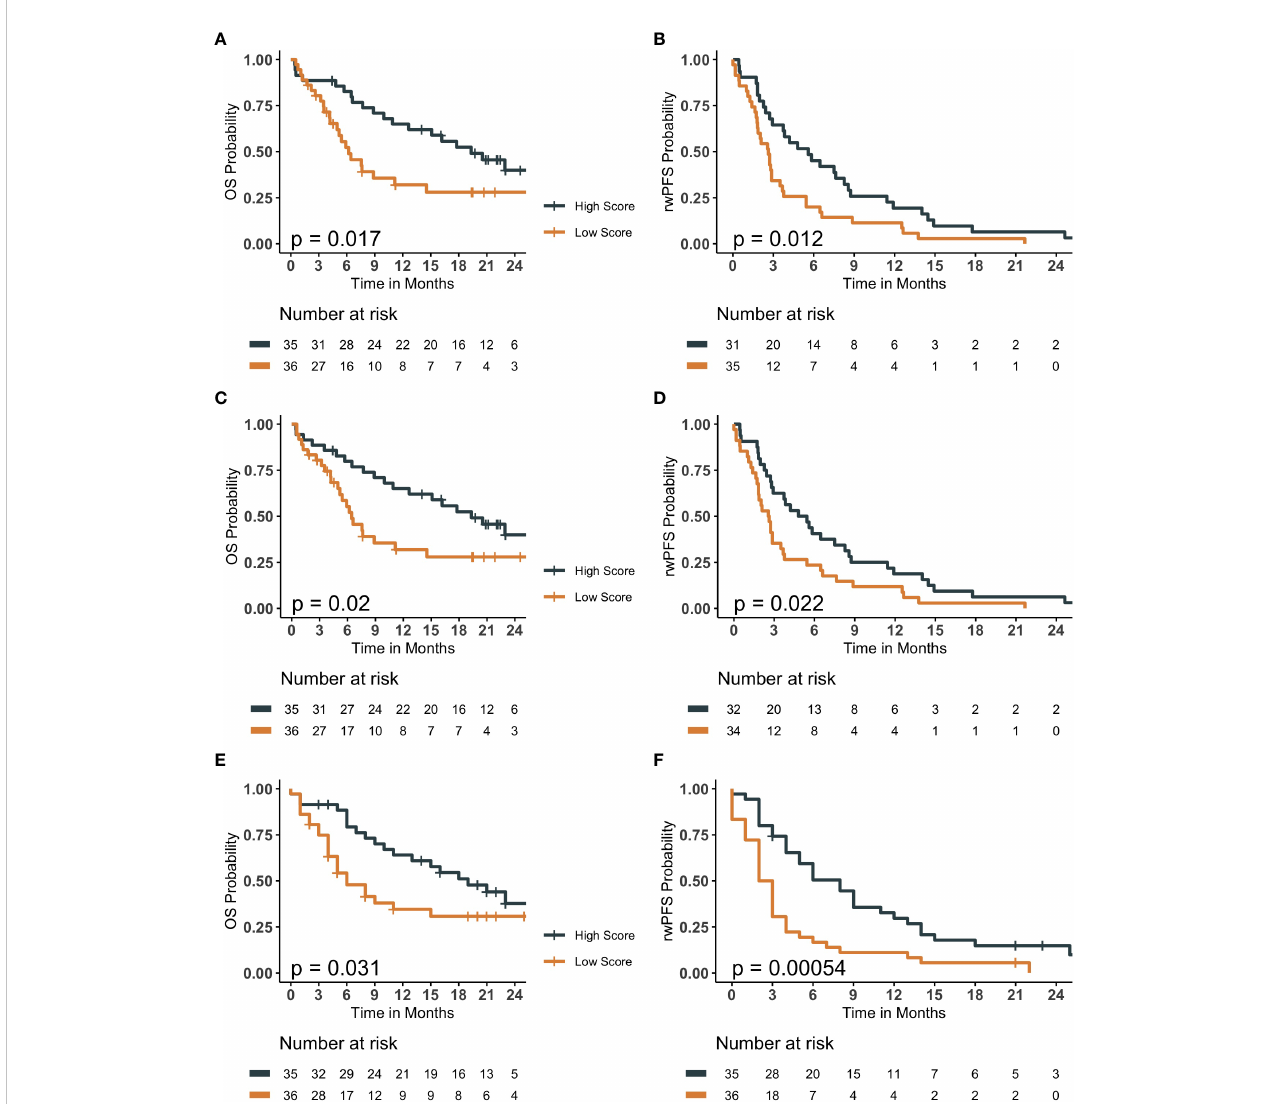
FIGURE 2 Kaplan Meier survival curves comparing patients assigned high survival scores compared to low survival scores for baseline and optimized logistic regression models in addition to elastic-net logistic regression model for overall survival (OS) and real-world progression free survival (rwPFS). Prediction results of baseline logistic regression models (A, B) , optimized logistic regression models (C, D) , and elastic-net logistic regression model (E, F) with Kaplan Meier survival plots. (A, C, E) are OS, with (B, D) , and F being rwPFS. Patients with survival scores higher than the median cut-off had signi fi cantly longer OS and rwPFS than those with lower survival scores. P-values less than 0.05 indicates a statistically signi fi cant probability from the log-rank statistical test that the high and low score groups have different survival